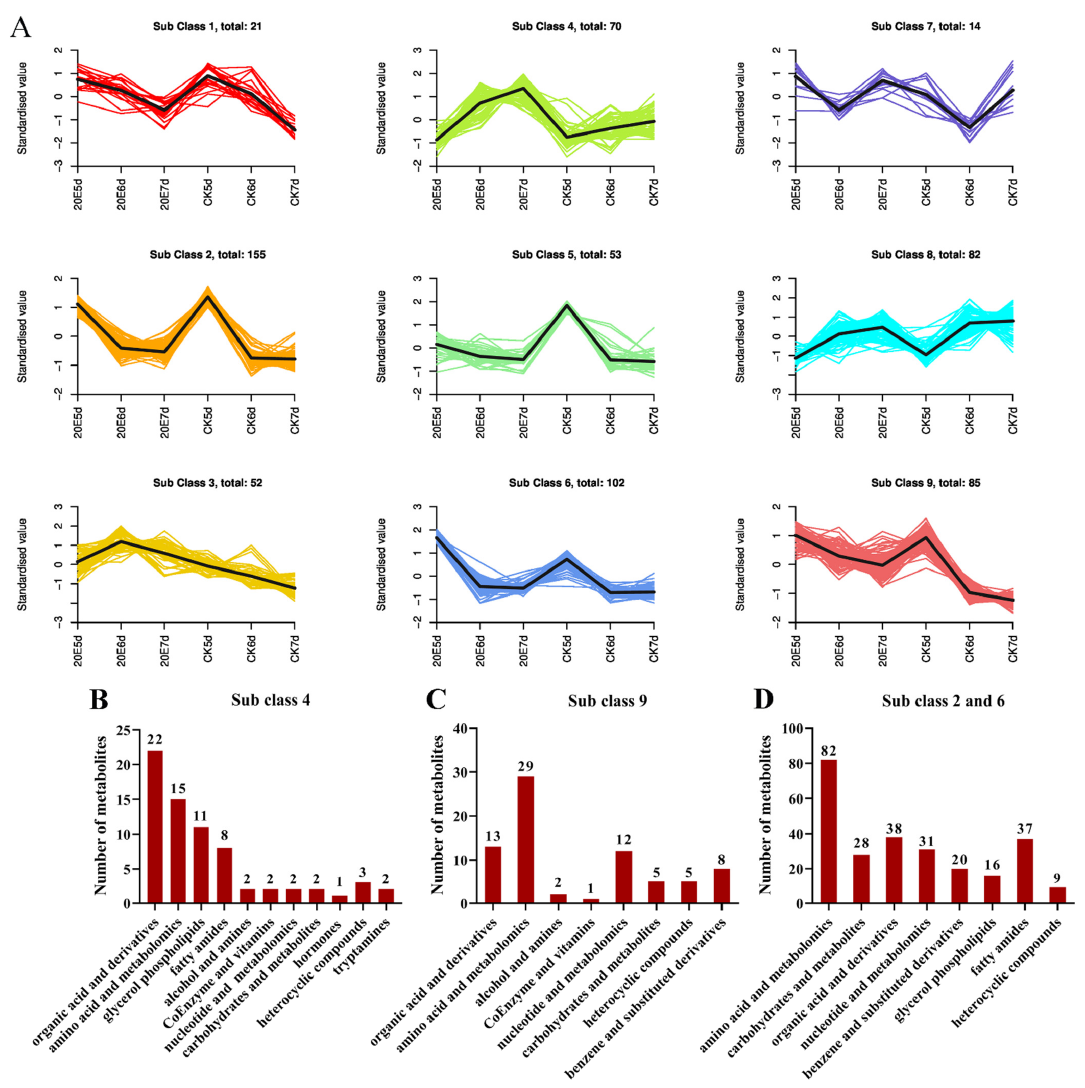
Figure 4. K-means clustering algorithm analysis of the dynamic alteration of the metabolites in three development states of larvae with 20E treatment. ( A ) K-means cluster was performed on Z-score normalized intensities. Classification of upregulated metabolites in Sub class 4 ( B ), Sub class 9 ( C ), Sub class 2 and 6 ( D ). Three biological replicates were analyzed for each group. Table 2. Classification of differential metabolites in pairwise